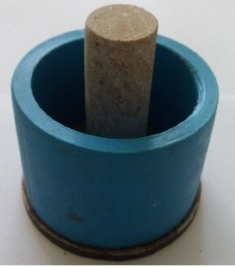
Figure 8. Sandstone core ready to be sealed with cement slurry.